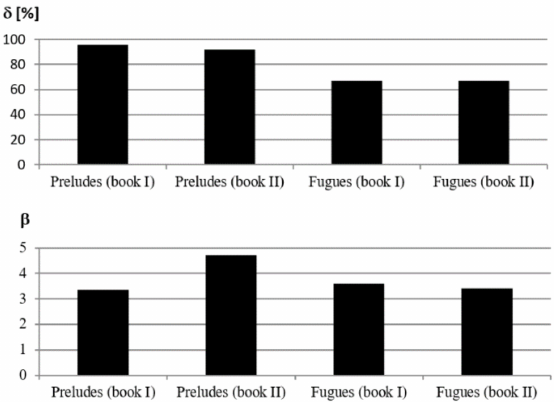
Figure 8. The efficacies of the proposed method obtained individually for particular collections by J.S. Bach. δ —the percentage of the music pieces for which the key signature was correctly recognized; β —the average number of notes required for the correct recognition of the music key